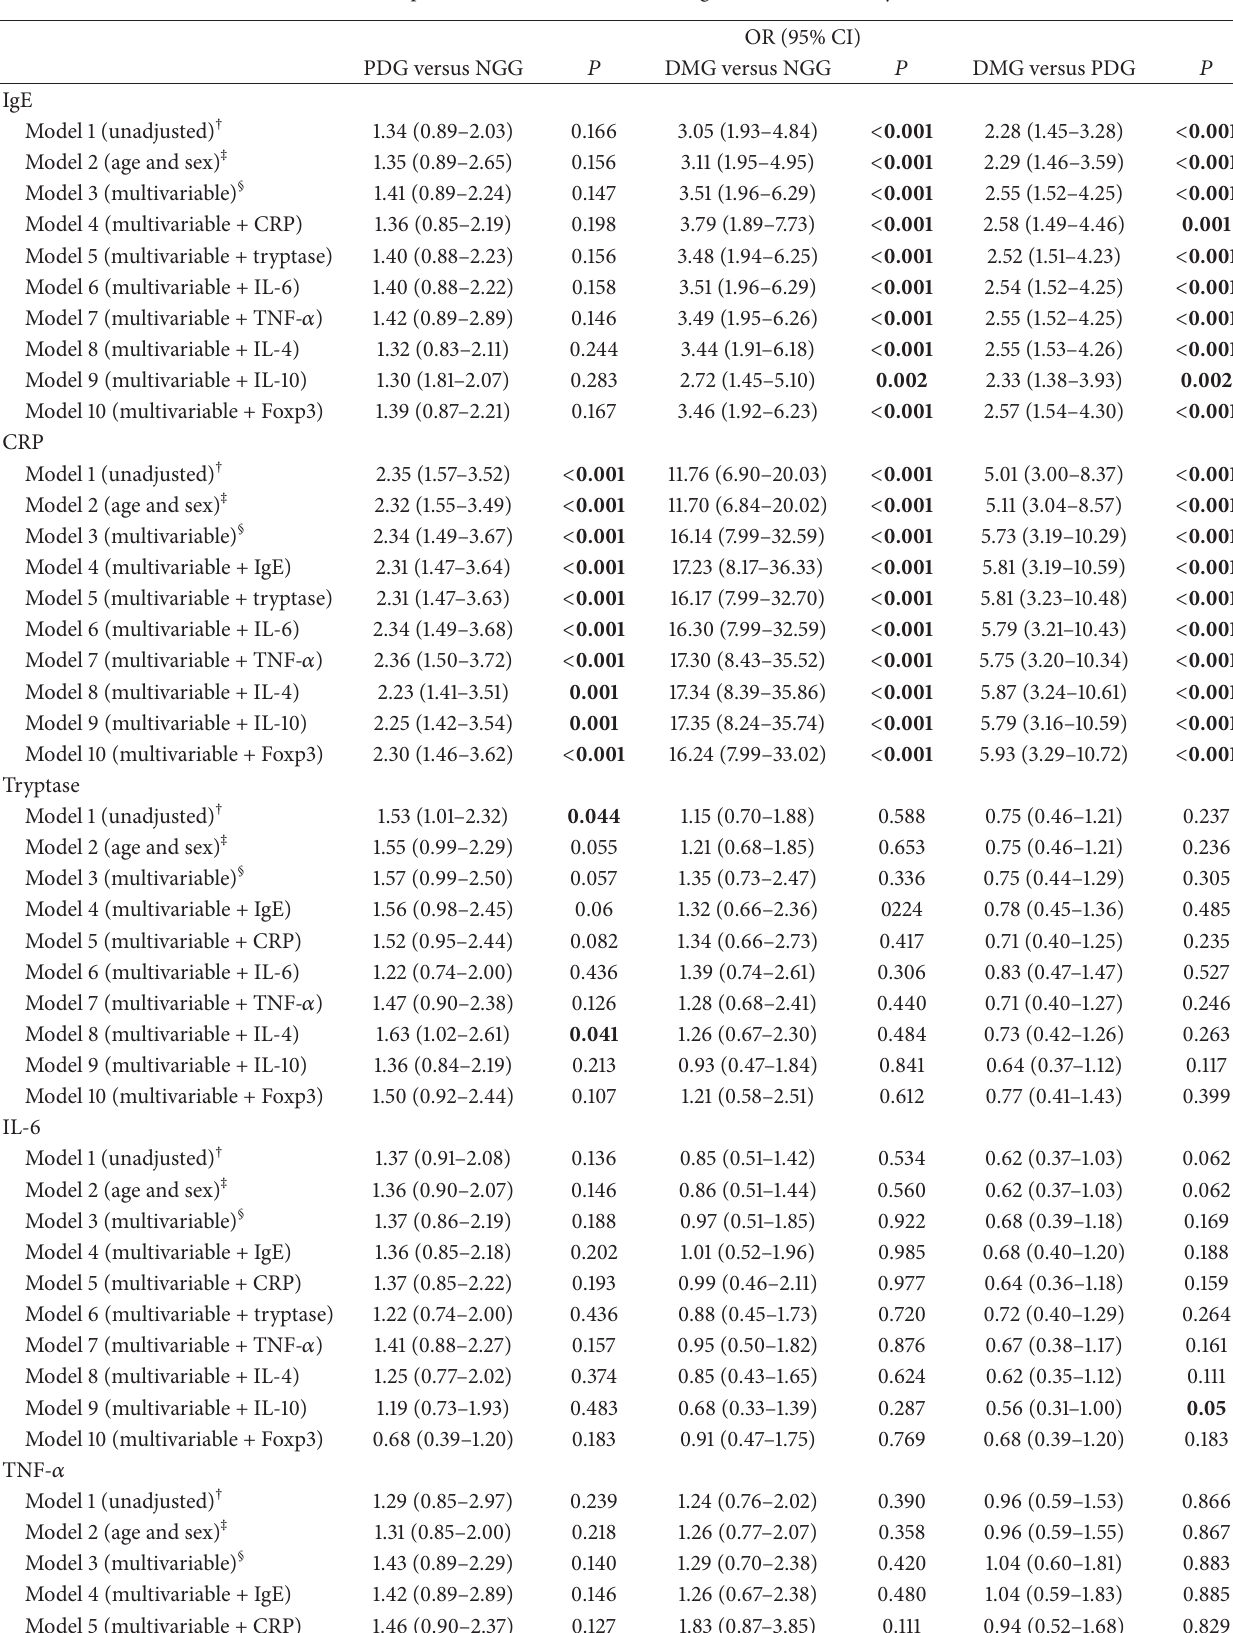
Table 5: ORs of prediabetes and T2DM according to the inflammatory